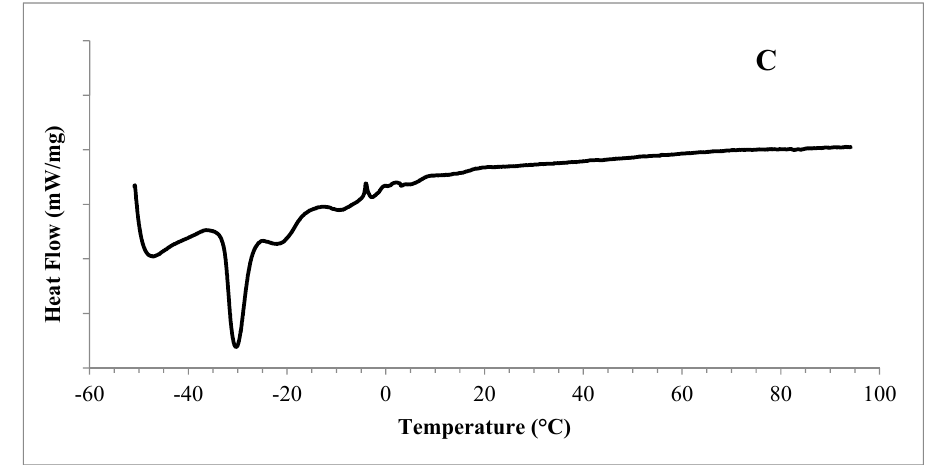
Figure 1. Melting thermograms of Silybum marianum L. seed oils native to Zaghouan ( A ), Sousse ( B ), and Bizerte ( C ).